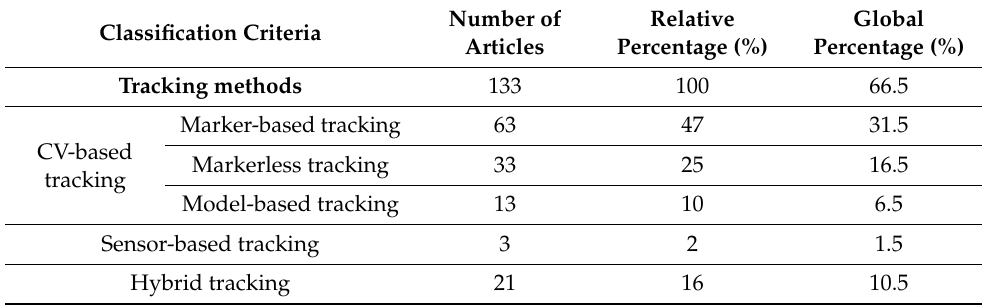
Table 14. Number of articles classified by tracking